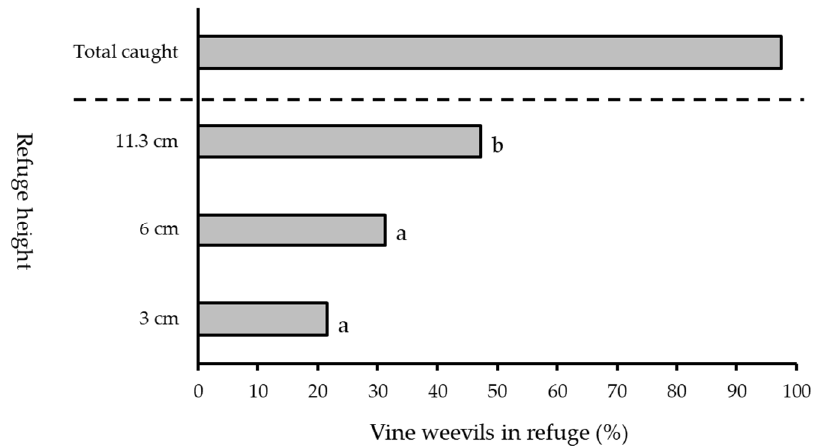
Figure 5. Percentage of vine weevil adults recorded in refuges with a height of 3, 6 or 11.30 cm when released as a group of ten individuals ( number of replicate days = 5). Different letters denote significant differences between means ( p < 0.05).